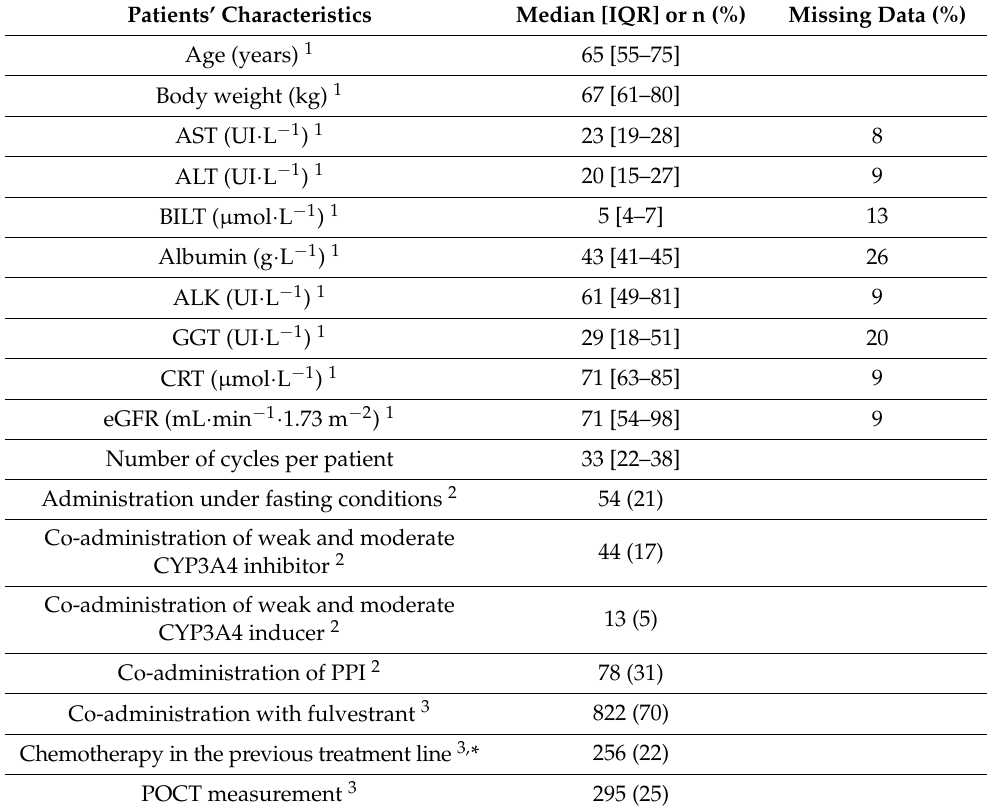
Table 1. Demographic and clinical characteristics of the study